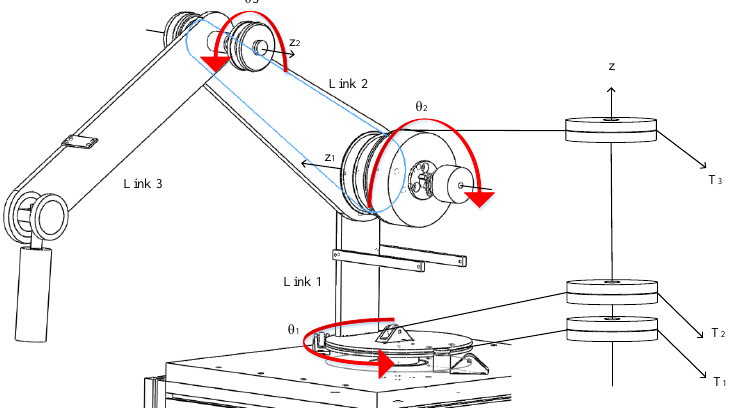
Figure 2. Transmission sketch of a robot arm.